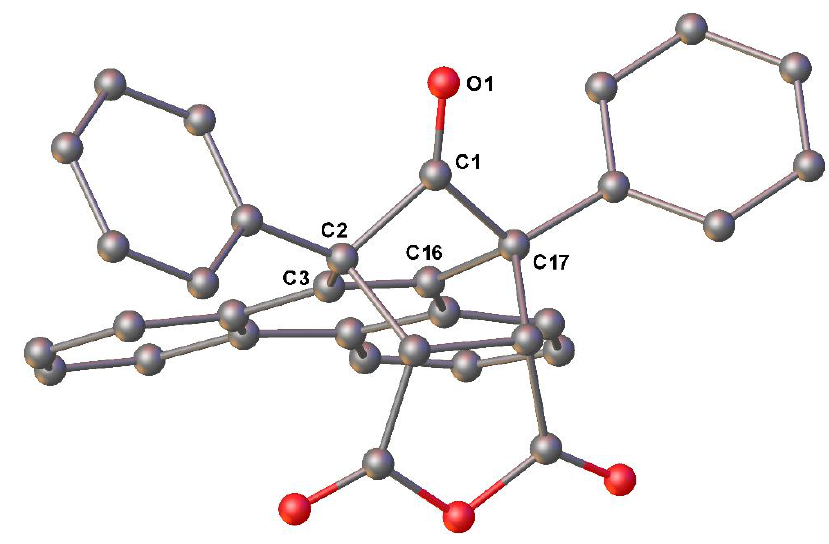
Figure 2. Crystal structure of 3 with key atoms highlighted and hydrogen atoms omitted.